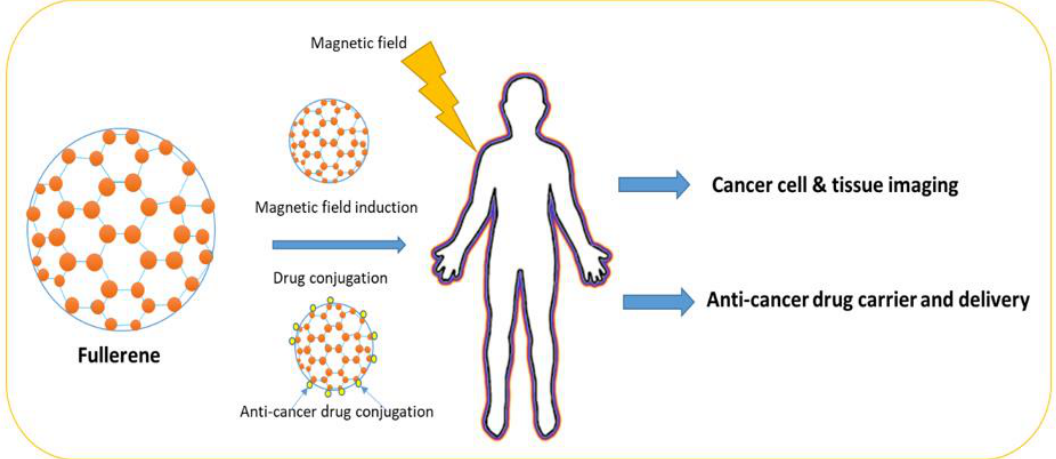
Figure 5. Fullerene structure and shape.